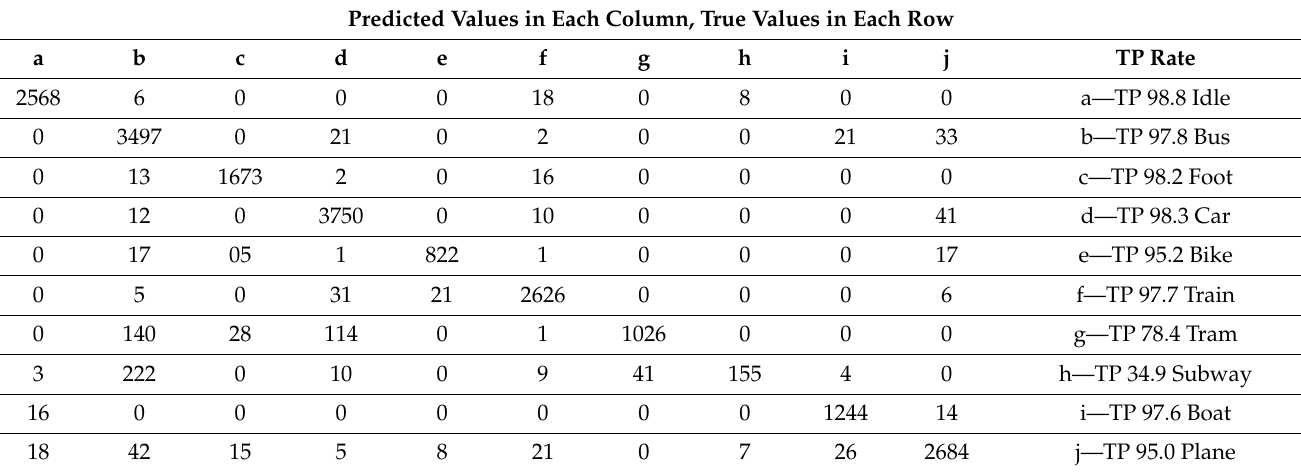
Table 8. Confusion matrix for the best results (2-fold cross-validation, RF, HSS 20). Predicted Values in Each Column, True Values in Each